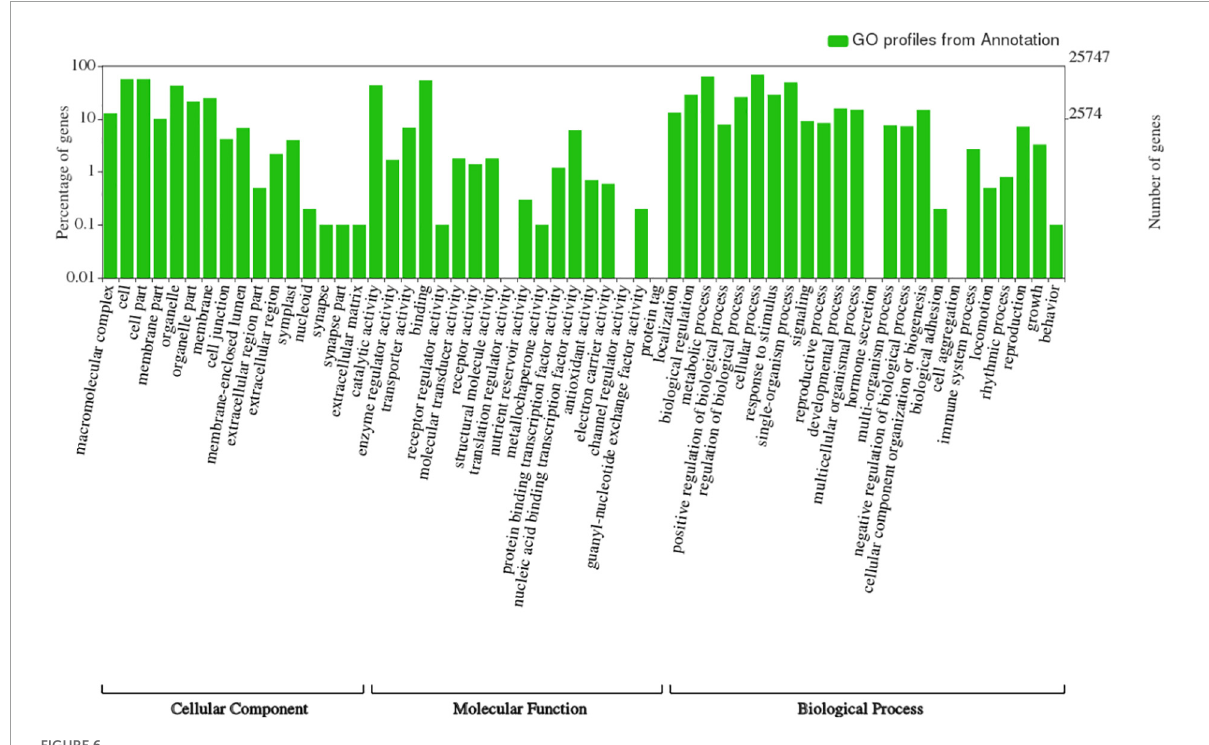
FIGURE6 Functional classification of genes from ‘Bhagawa’